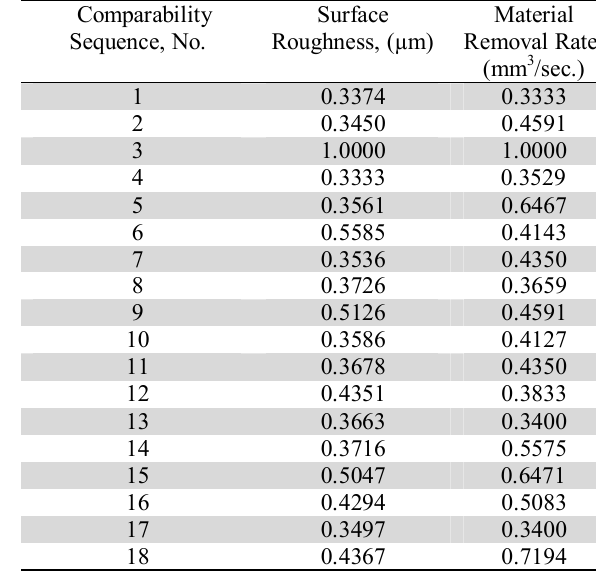
Quality Loss Function Grey Relational Coefficients for 18 Comparability Sequence